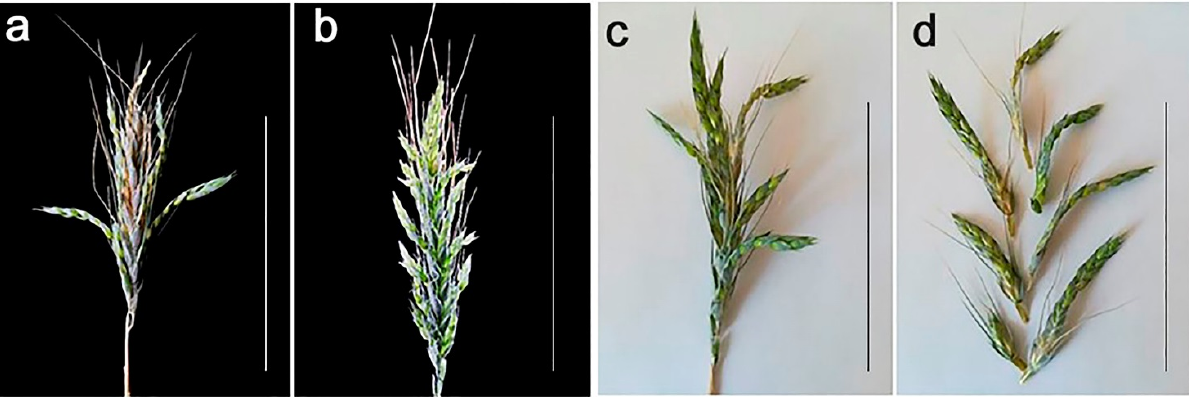
Figure 3. Vaviloid type of spike branching. Spike of Line 808/1 plant ( a ); spike of Line 844/4 plant ( b ); intact spike of Line 808/1 plants ( c ); and the same spike divided into spikelets ( d ). Scale bar: 10 cm.